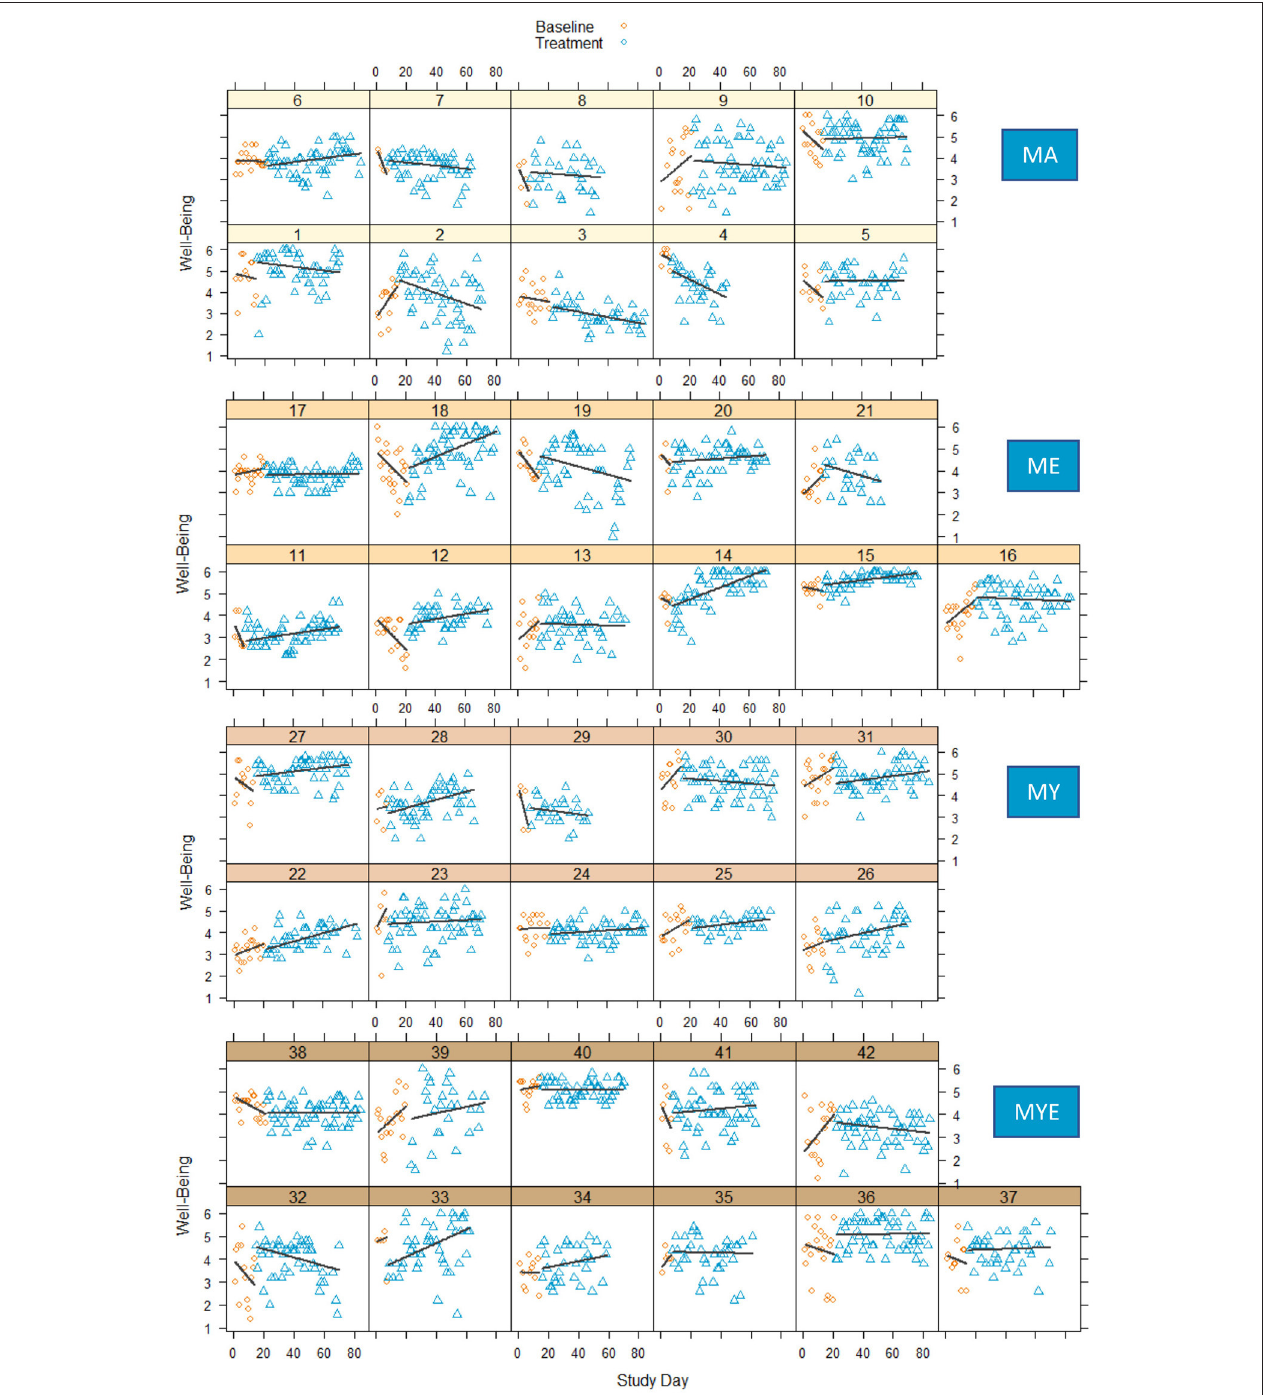
FIGURE 3 | Well-Being scores in four conditions during baseline and treatment phases for each participant with regression lines for each phase. MA, Mantra meditation only; ME, meditation and ethical education; MY, meditation and physical yoga; MYE, meditation, physical yoga, and ethical education.